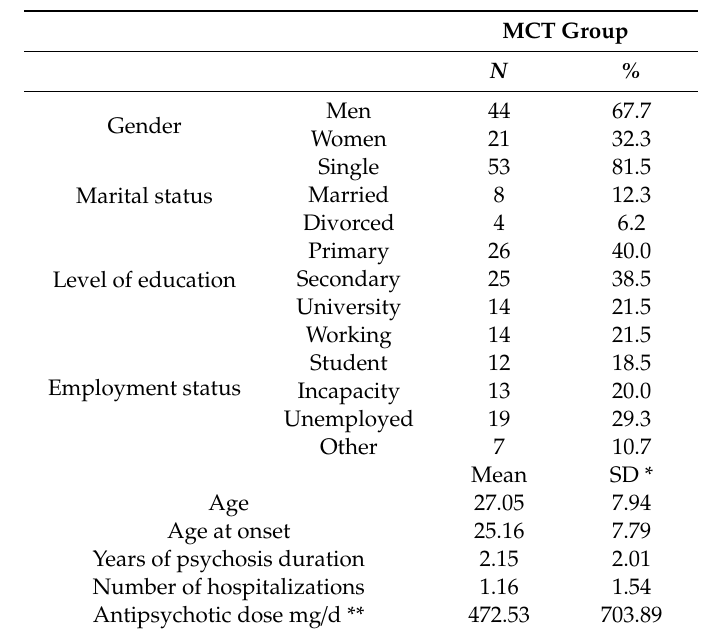
Table 1. Socio-demographic characteristics of the sample. MCT, metacognitive